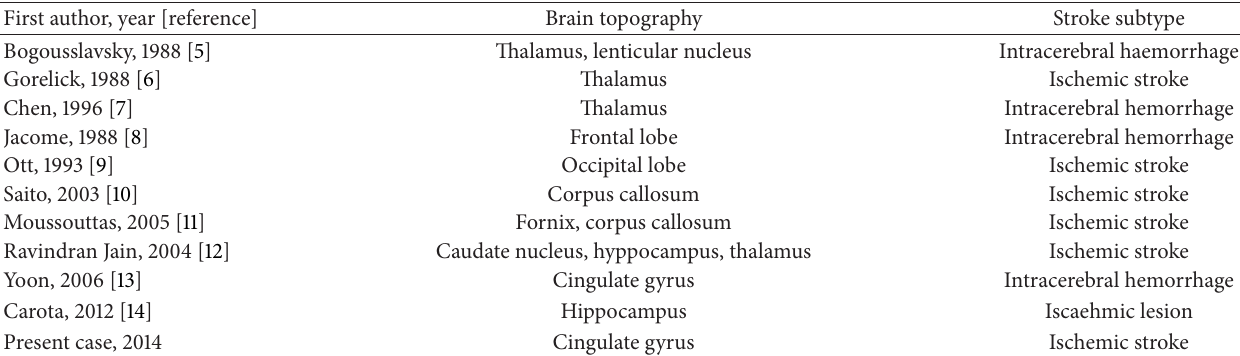
Table 1: Main studies of TGA associated with acute stroke reported in the